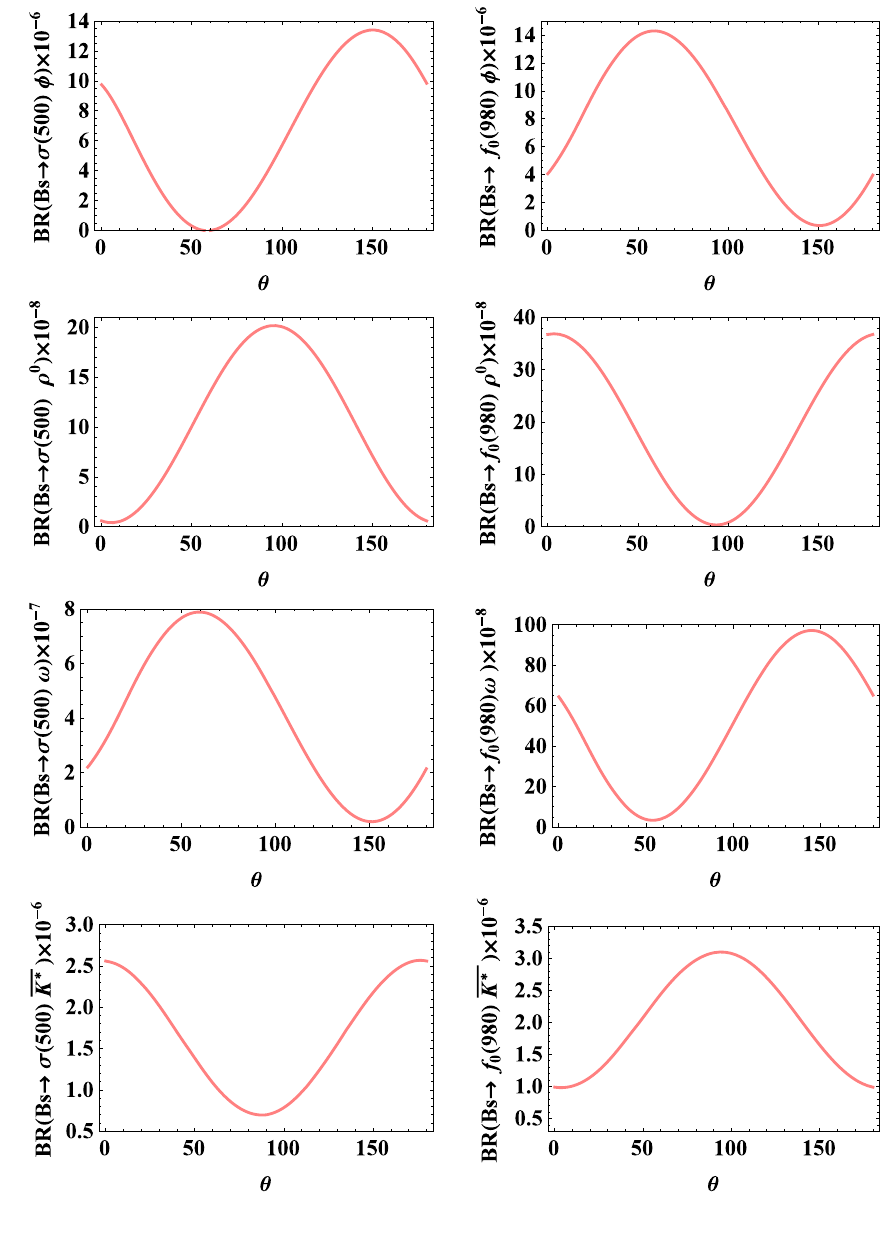
Fig. 2 The branching fractions of the B s → f 0 ( 980 ) [ σ ] V decays versus the f 0 ( 980 ) − σ mixing angle